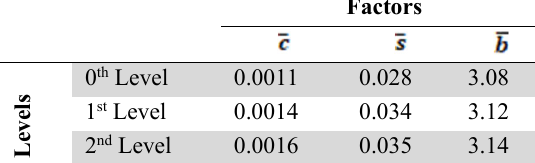
Values of factors at each level